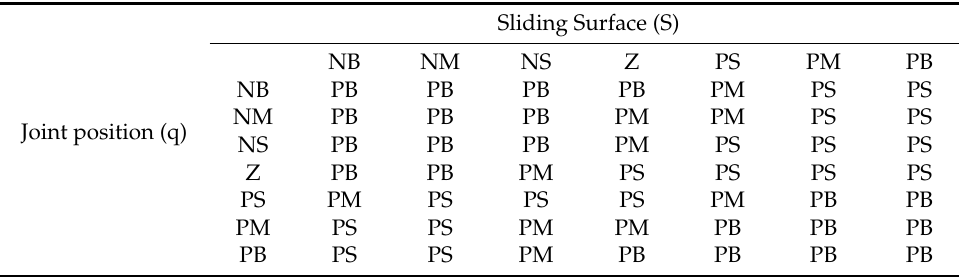
Table 1. Fuzzy rule table for the adaptive fuzzy sliding mode estimation algorithm.